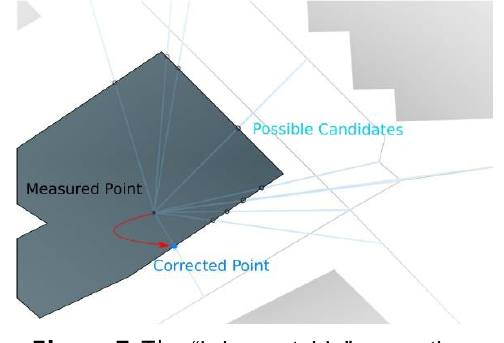
Figure 7 . The “bring-outside” correction.